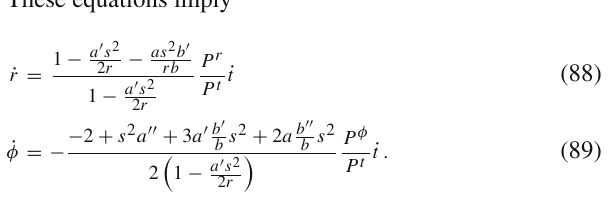
= 1, E = 1, j = − 0 . 5; left 1